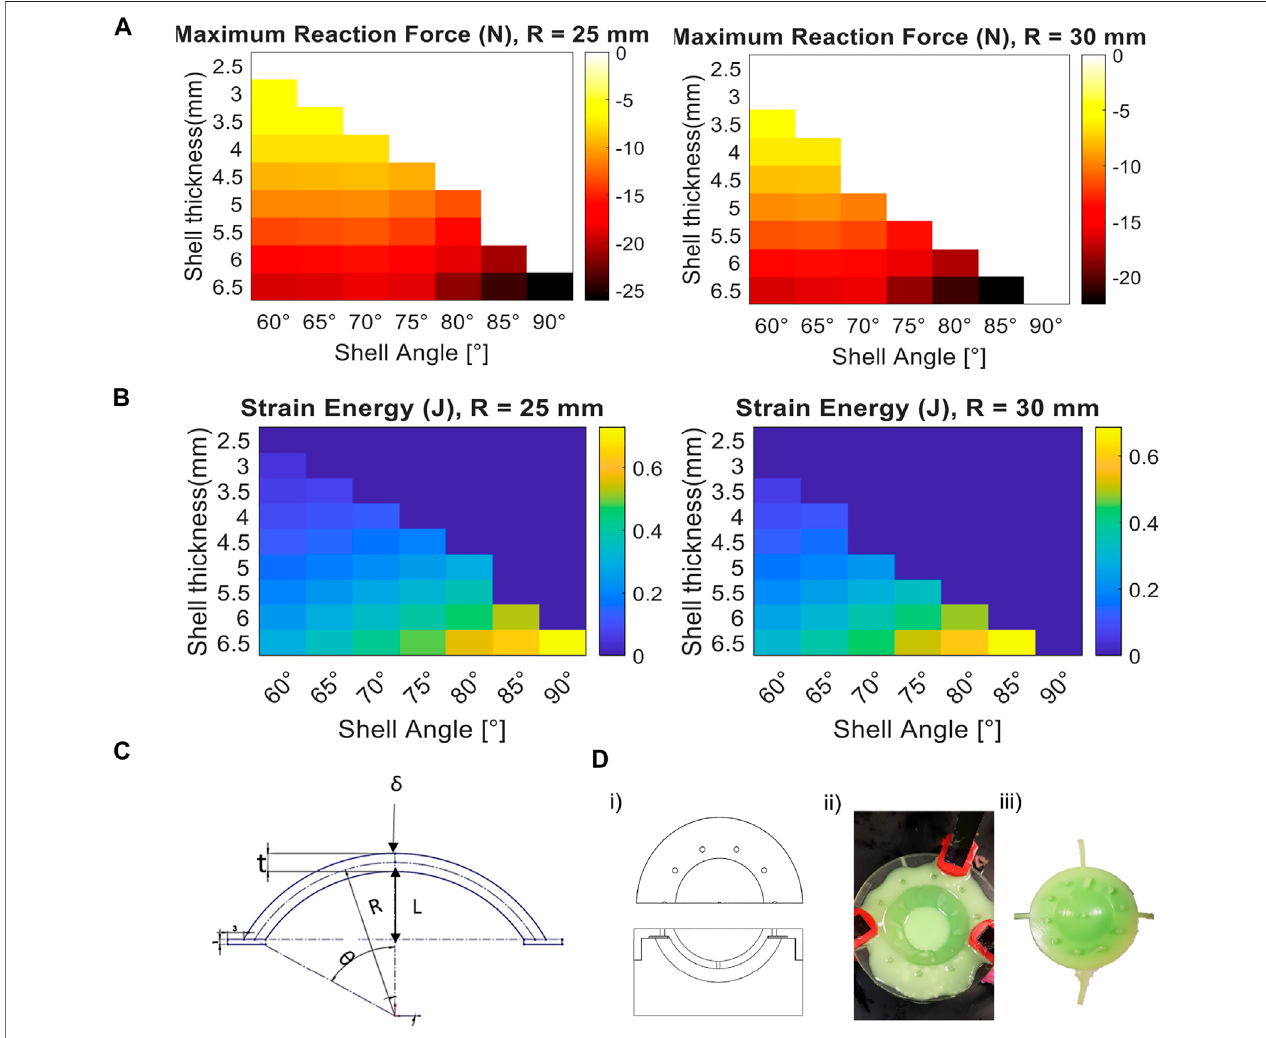
FIGURE 2 | Design requirements for energy storage in snap-backing shells and their fabrication process. (A) Heat map from simulation of the maximum force required to invert the snap-backing shells, for various shell geometries (white regions indicate the corresponding shells that do not self-snap-back). (B) Heat map of the strainenergyoftheshellsin (A) whentheirgeometryvaries(darkblueregionsindicatethecorrespondingshellsthatdonotself-snap-back). (C) Schematicofthetunable parametersusedinthesimulation,where R istheradiusoftheshell, fi xedperdesignspaceexplored, δ istheprescribeddisplacement, L istheverticaldistancefrom thesymmetriccenteroftheshelltohalfofitsthickness( t ),and θ istheangleofcurvatureoftheshell. (D) Castingprocessforthefabricationoftheshell,fromlefttoright: (i) top and side view of the schematic of the mold used for casting (left), (ii) clamped mold inserted into the pressure chamber (middle) containing silicone-based material, (iii) and removed part with remaining